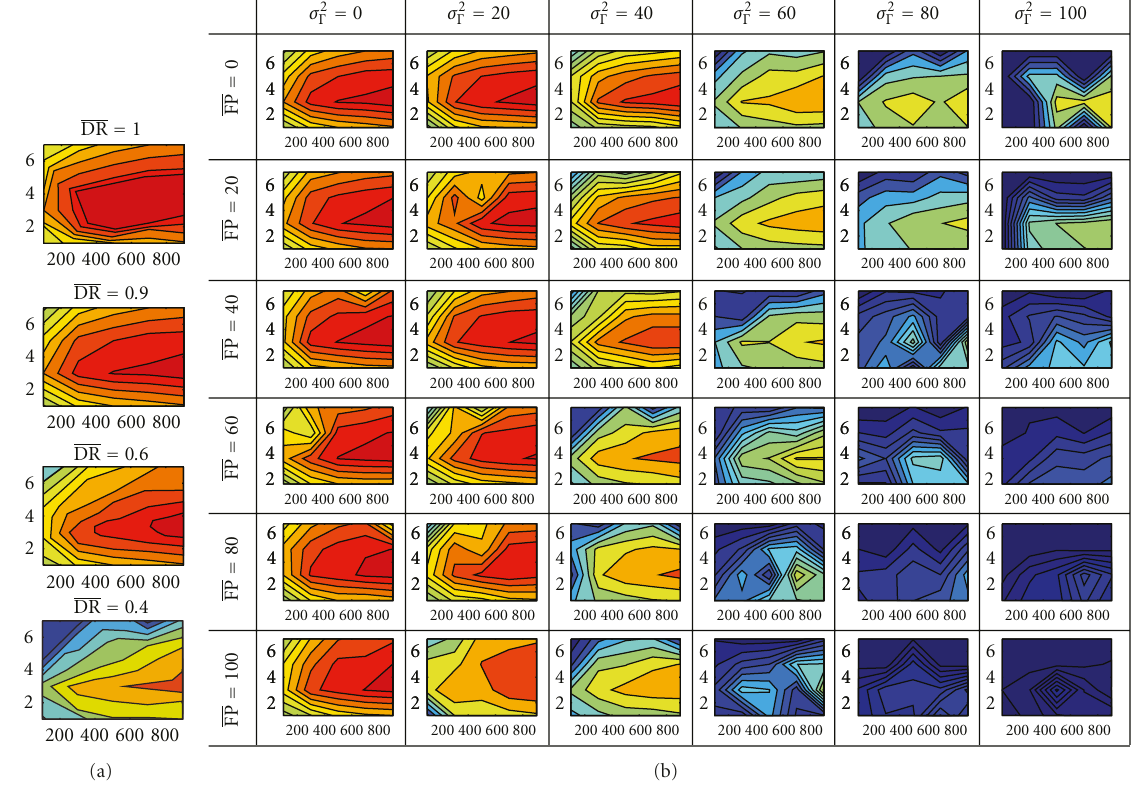
Figure 6: Quantitative results over the HumanEva data set where score MMTA is displayed in pseudocolor. In all plots, y -axis accounts for the number of layers L and x -axis for the number of particles per layer N p . In (a), assuming an ideal case where FP = 0 and σ 2 Γ = 0, impact of the number of occlusions, regarded by DR in the overall performance. In (b), assuming a fixed occlusion level DR = 0 . 85, results for the cases FP = { 0,20,40,60,80,100 } and σ 2 Γ = { 0,20,40,60,80,100 }